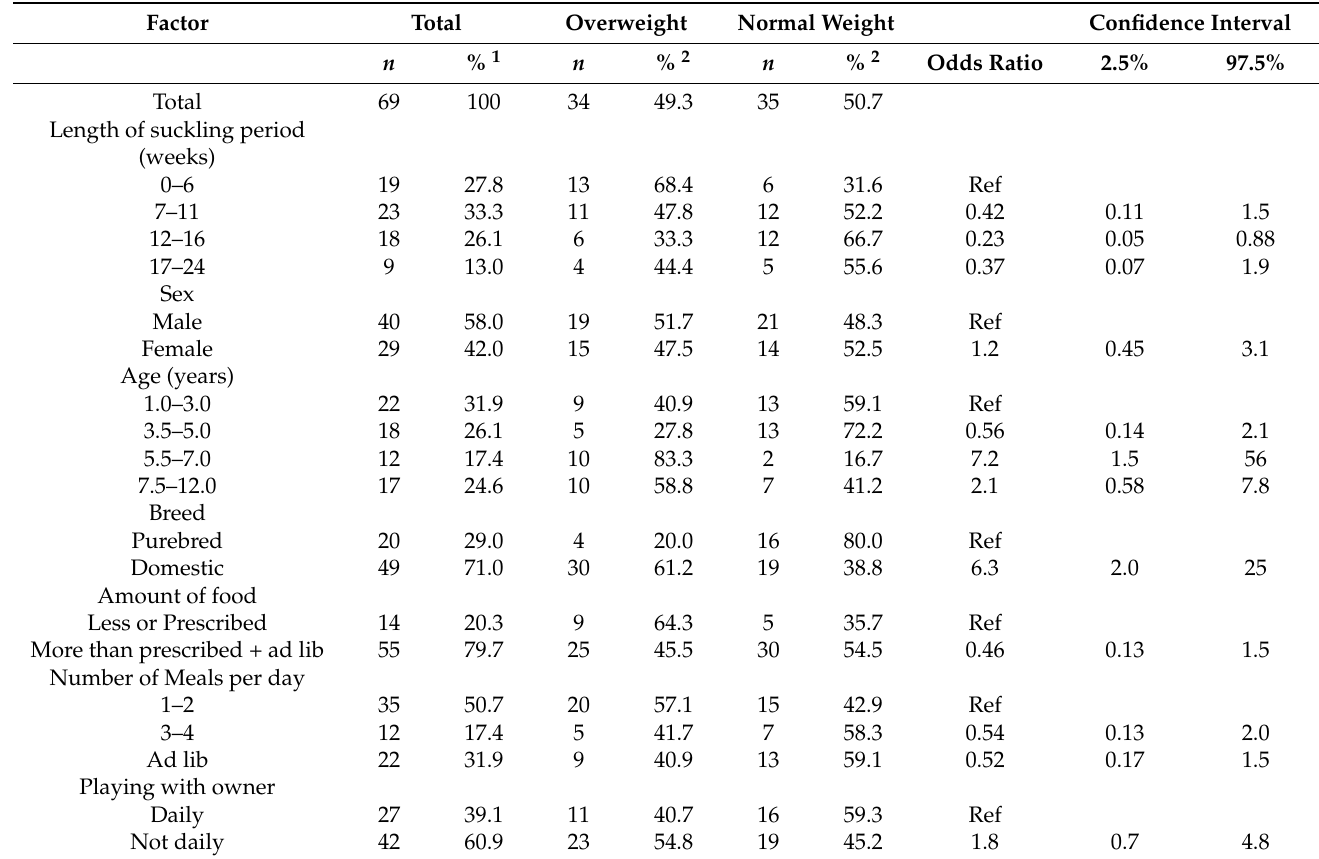
Table 2. Univariable analysis of the cats ( n = 69): Number (%) of cats per demographic factor against overweight status and unadjusted odds ratio with 95%